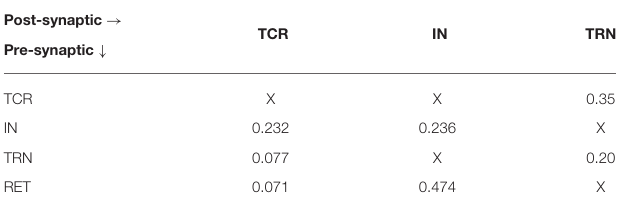
TABLE 1 | Normalized base parameter values of synaptic projection from the pre-synaptic population to the post-synaptic population expressed as a probability p conn ∈